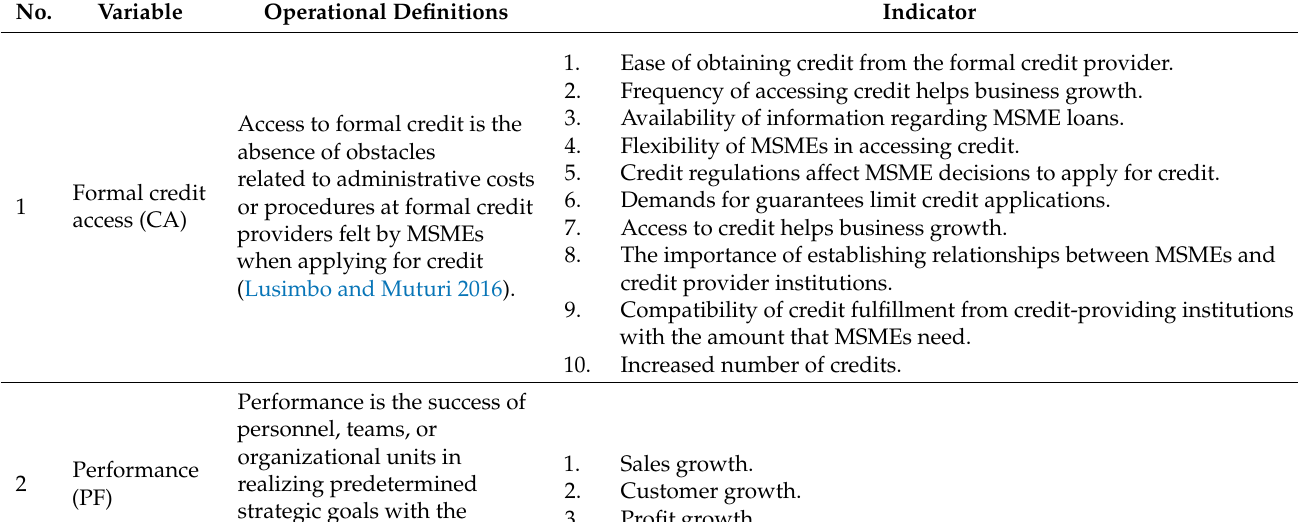
Table 1. Definition of Operational